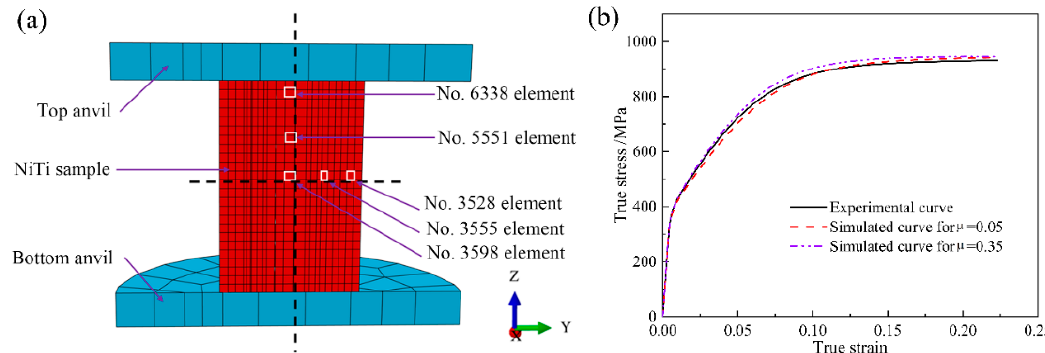
Figure 5. ( a ) Schematic diagram of the finite element modeling of uniaxial compression of NiTi shape memory alloy via ABAQUS code. (No. 6338 element is in the minimum deformation zone. No. 5551 element is located between the minimum deformation zone and the principal deformation zone. No. 3598 element is in the principal deformation zone. No. 3555 element is located between the principal deformation zone and the intermediate deformation zone. No. 3528 element is in the intermediate deformation zone.); ( b ) True stress-strain curves with respect to the experimental measurement and finite element modeling in the case of friction coefficients of 0.05 and 0.35 at the deformation degree of 20%.